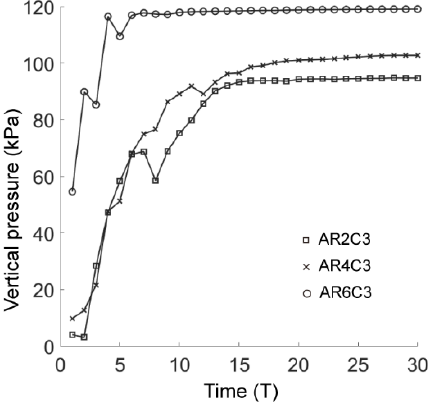
Figure 25. Average vertical pressure on the tunnel lining as a function of computational time in all three cases of C = 0.99.